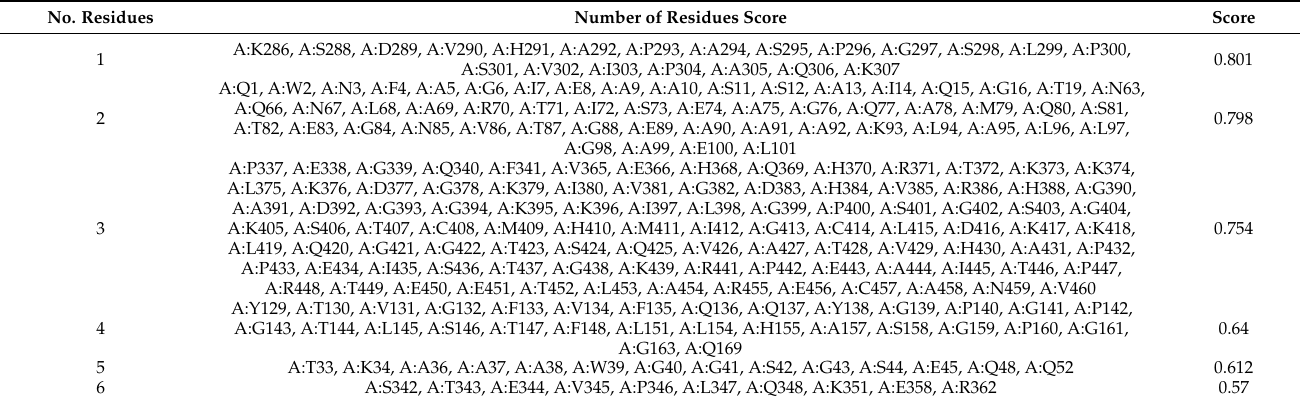
Table 7. Discontinuous B-cell epitopes predicted by the ElliPro.